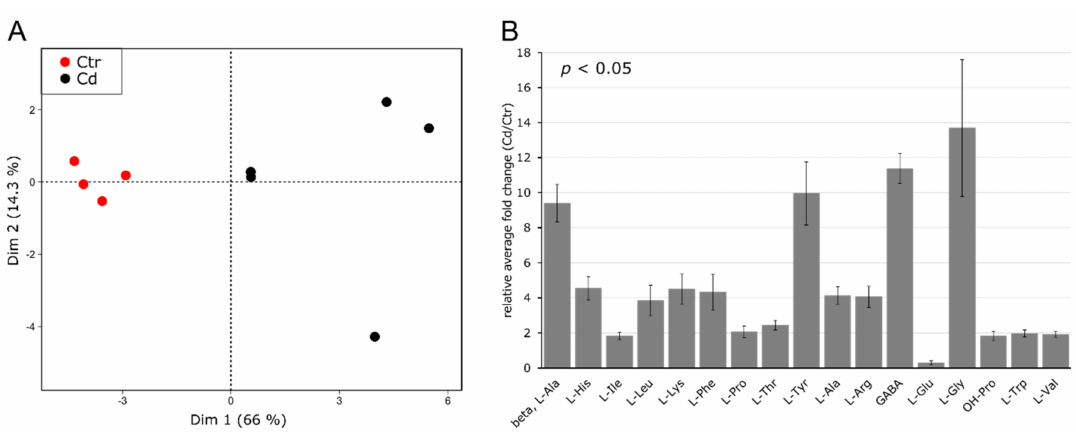
Figure 3. Amino acid profile in M. sativa leaves after long-term exposure to Cd (10 mg kg − 1 soil dry weight). Amino acids were measured using GC–MS ( n = 4 to 5). ( A ) Principal component analysis. Dim 1 and 2 represent together 80.3% of the observed variance ( B ) relative fold change of significantly changed AA ( ± SEM). Significance was determined with a t -test at p ≤ 0.05. Absolute values for all AAs are provided in Table S4.